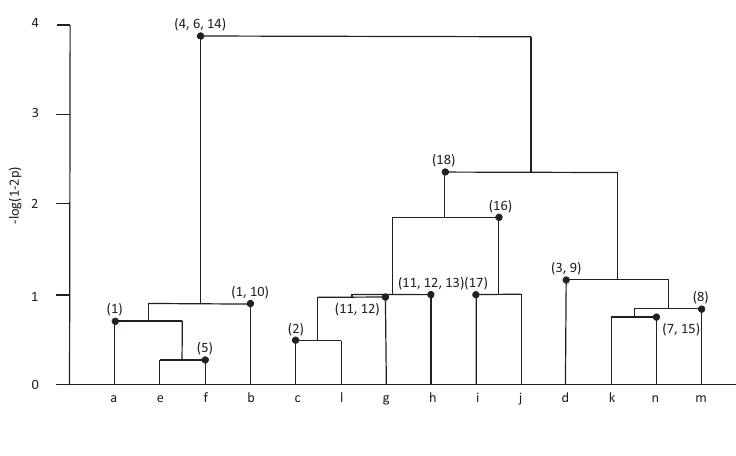
Figure 1. An example of the mixture tree